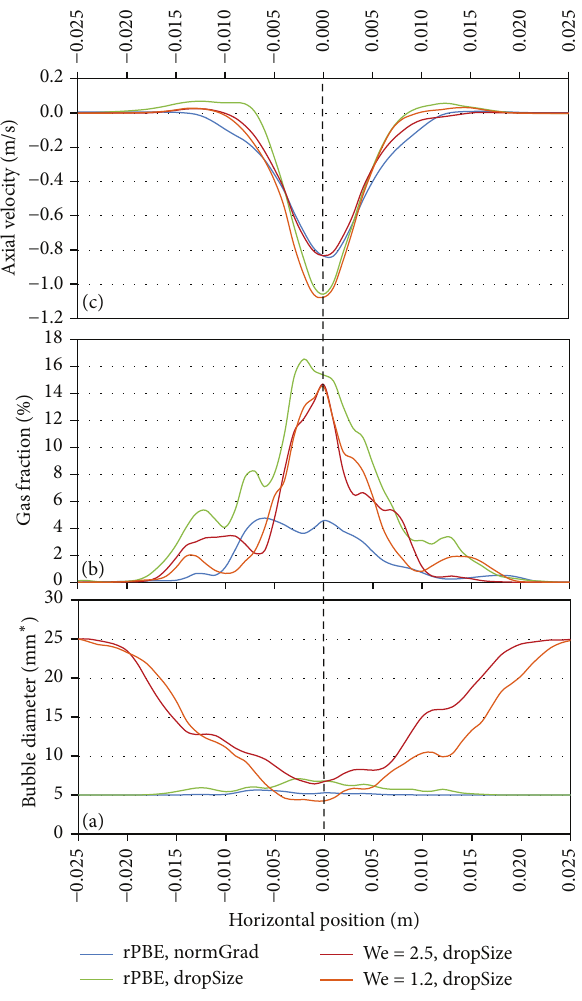
Figure 10: Plots on a horizontal line at the liquid midheight for the four cases showing (a) the predicted bubble diameter for multifluid region,(b)thegasfraction,and(c)theaxialvelocityprofiles.Vertical dashed line shows the jet axis.